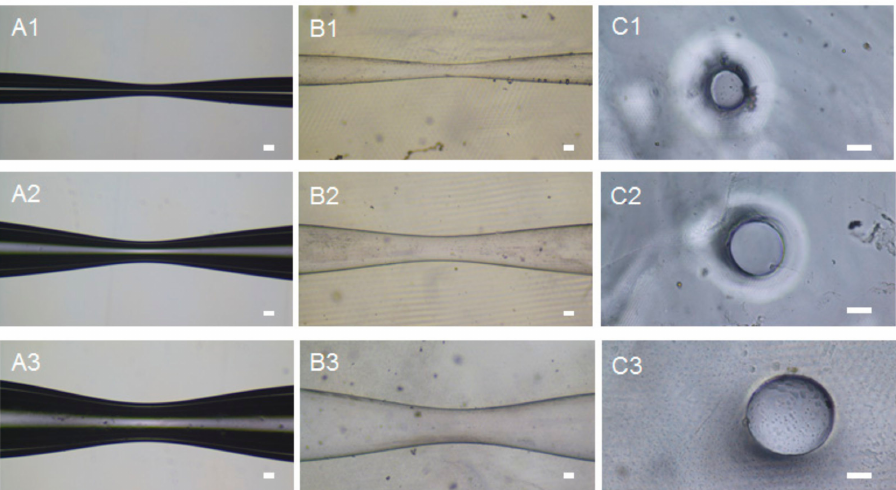
Figure 1. The tapered capillary tubes and engineered microchannels: ( A1 – A3 ) Photographs of the tapered capillary tubes; ( B1 – B3 ) Photographs of the gelatin chip with microchannels after removing the capillarytemplatesandperfusedwithdistilledwater; ( C1 – C3 )Cross-sectionalviewofthemicrochannels at the narrowest point. Scale bar, 100 µ